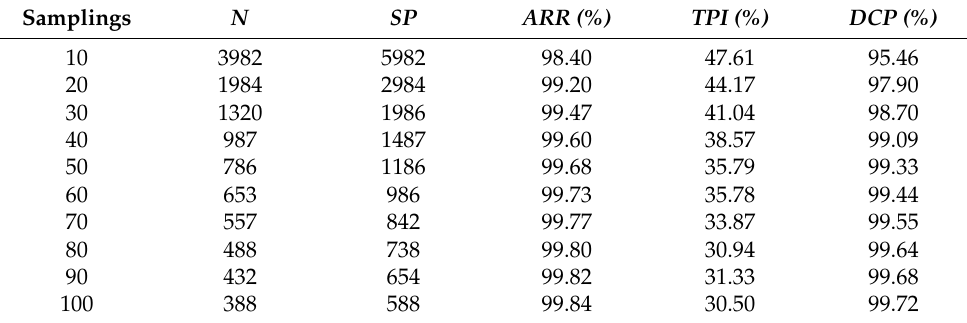
Table 2. The intervisibility results for different 3D point